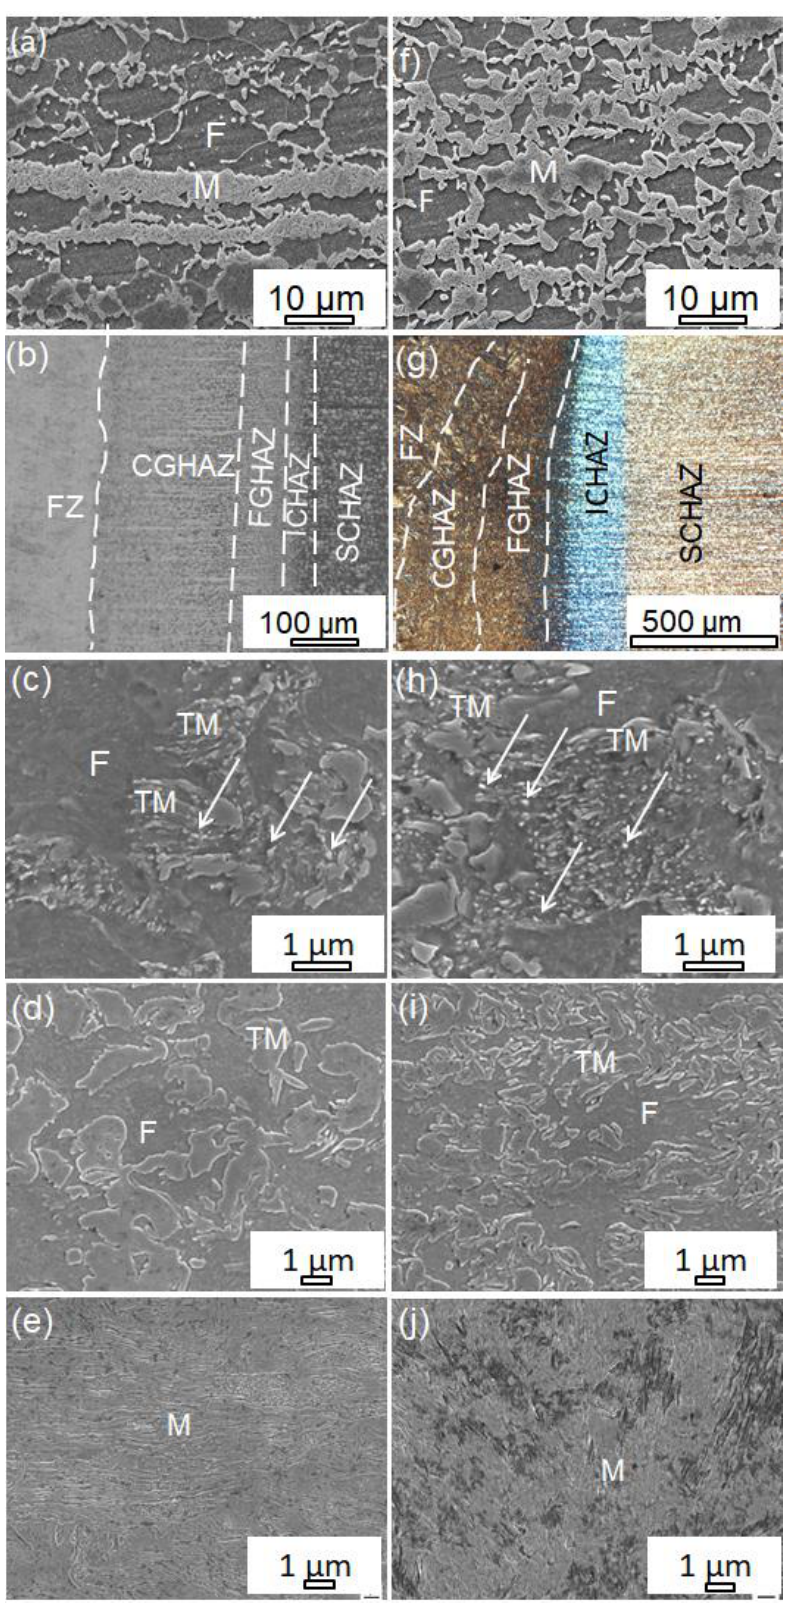
Figure 3. SEM and optical micrographs of welded DP800 joint: ( a ) BM; ( b ) Overview of HAZ; ( c ) SCHAZ; ( d ) ICHAZ; ( e ) FZ; and welded DP1000 joint: ( f ) BM; ( g ) Overview of HAZ; ( h ) SCHAZ; ( i ) ICHAZ; ( j ) FZ.